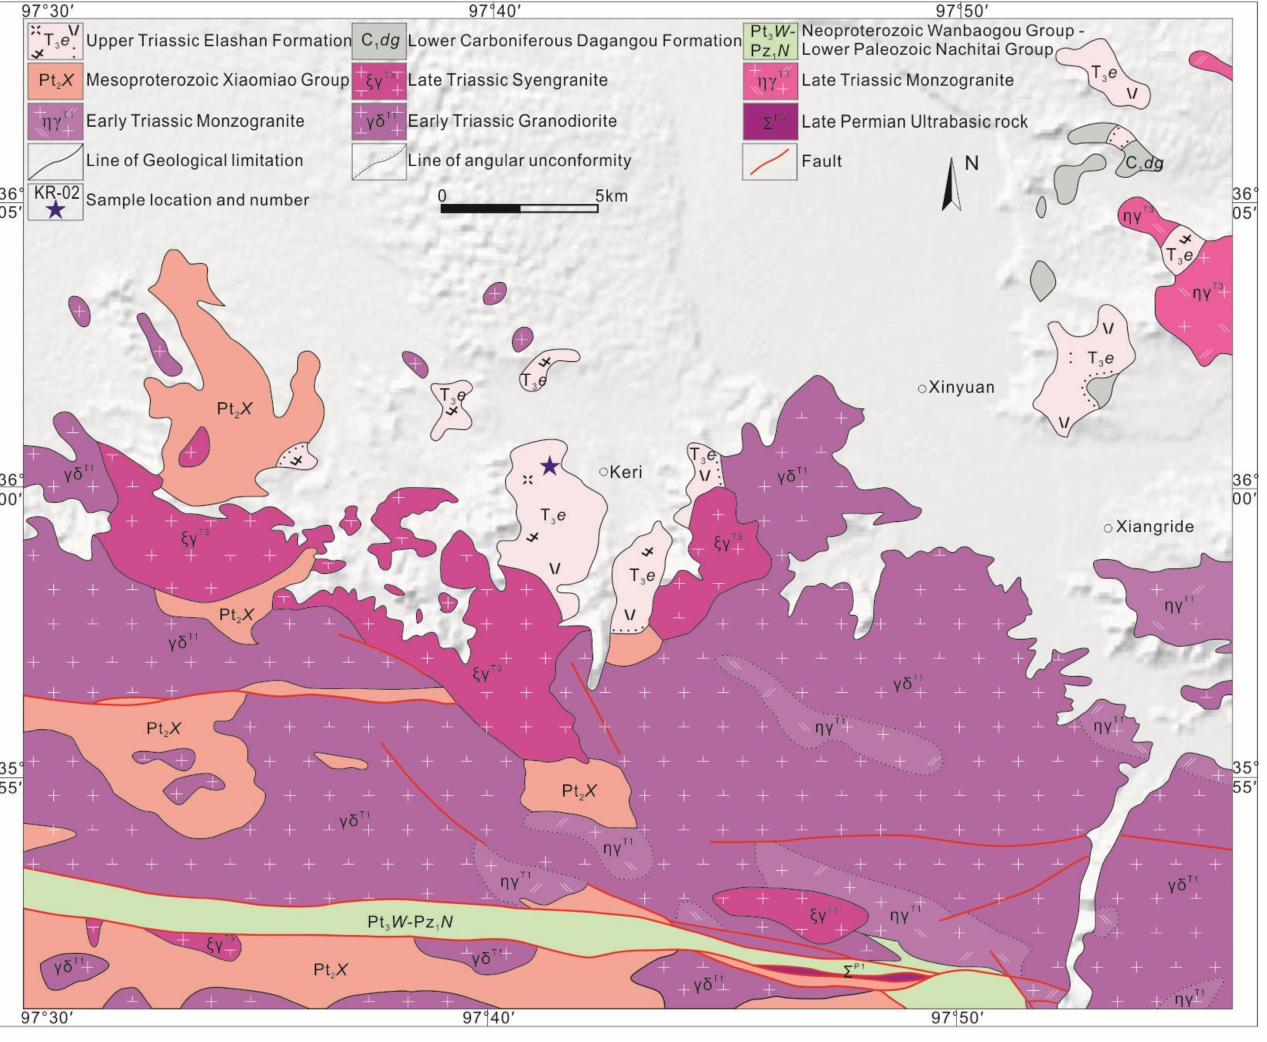
Figure 2. Map showing the regional geological of the Keri rhyolites in the EKOB. Geological map after Yin et al. [60]; Topographic map data: https://map.tianditu.gov.cn/ (accessed on 10 January